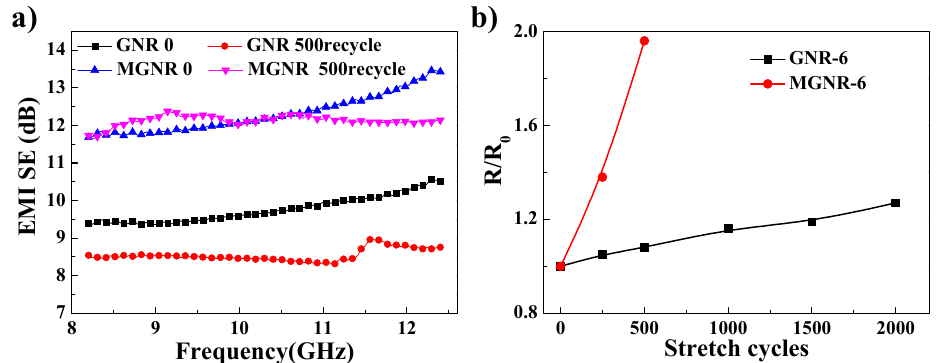
Figure 8. ( a ) The EMI SE of the MGNR-6 and GNR-6 composites before and after stretching for 500 cycles; ( b ) the R/R 0 as a function of the stretching cycles for MGNR-6 and GNR-6 composites (the thickness was 0.6 mm).